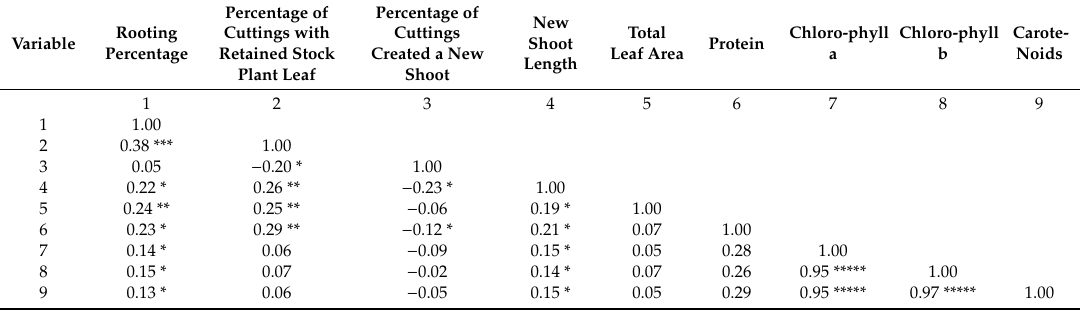
Table 3. Correlations matrices between rooting percentage and growth parameters, pigments, and soluble proteins content for cuttings derived from all phenological stages of shoots together in Rosa ‘Maiden’s Blush’.